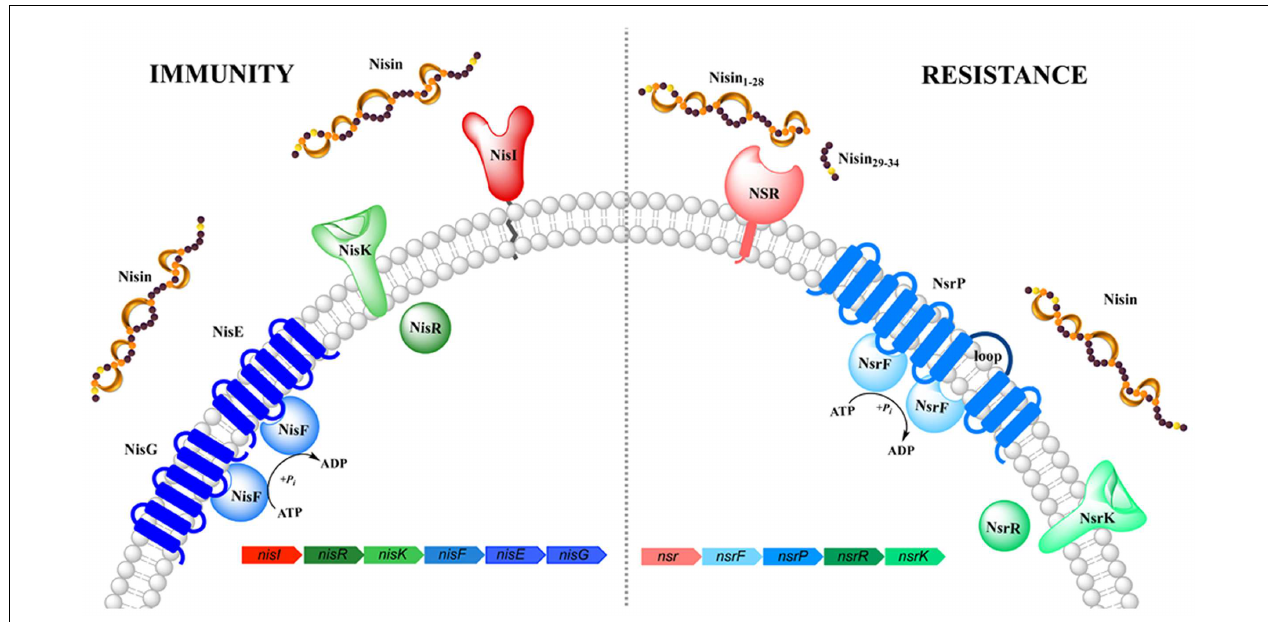
FIGURE 1 | Schematic representation of the nisin (auto-)immunity and resistance system. Both systems comprise of a lipoprotein/membrane-associated protein (colored in red/pink, respectively), an ABC transporter (depicted in blue) and a two-component system (shown in green). Functionally similar genes are color coded identically with the exception of NisI and